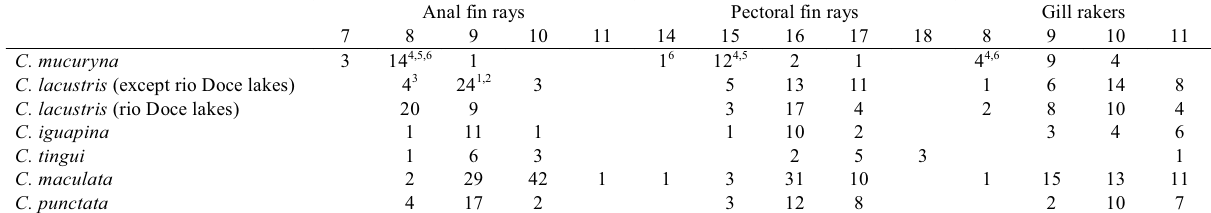
Table 7. Lateral-line scale frequencies in species of Crenicichla from southeastern Brazil. 1 MNHN A 9501 (126.0 mm), syntype of C. lacustris ; 2 FMNH 54155 (117.0 mm), holotype of C. dorsocellata ; 3 MZUSP 1781 (150.0 mm), paratype of C. biocellata